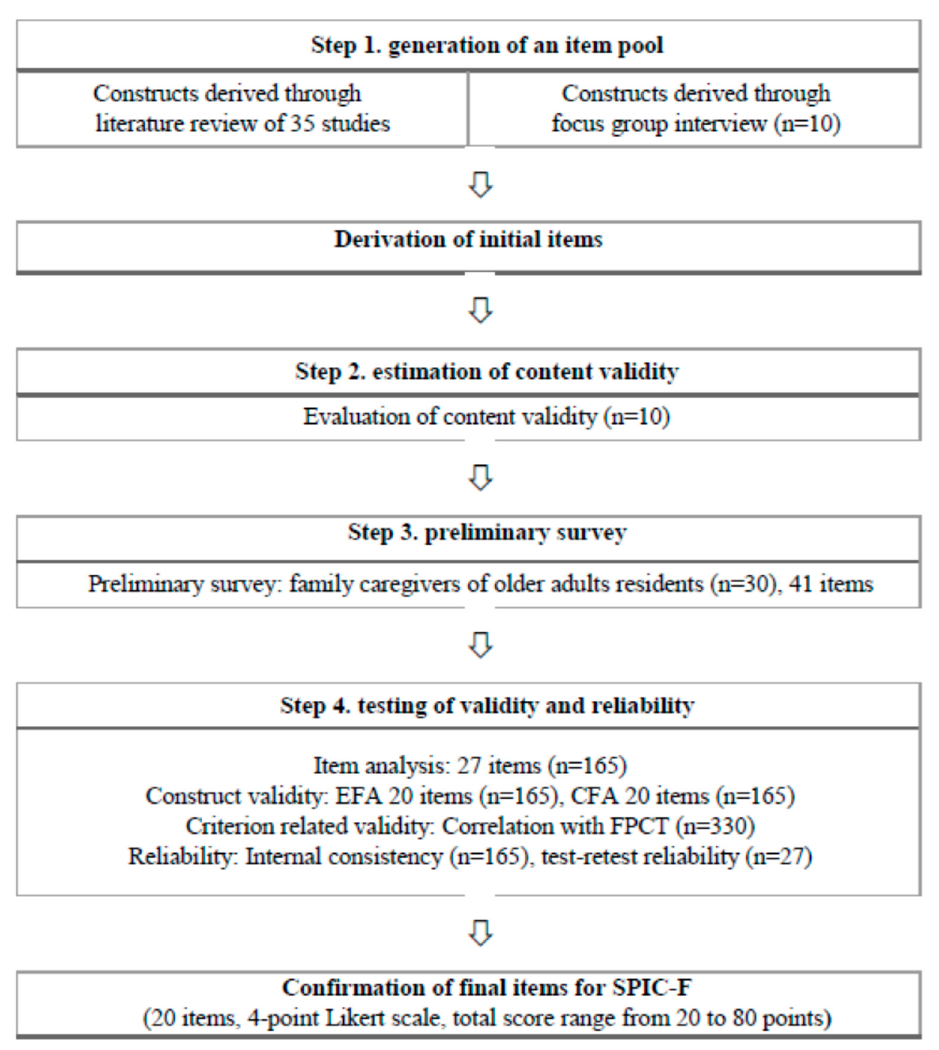
Figure 1. The SIPC-F development process. Notes. EFA = exploratory factor analysis; CFA = confirmatory factor analysis; FPCT = family perceptions of care tool; SPIC-F = scale for partnership in care—for family.